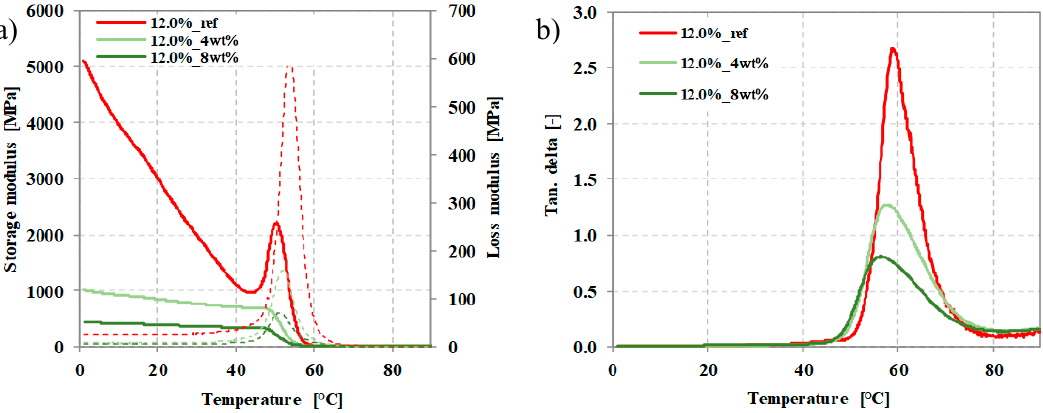
Figure 13. ( a ) Storage and loss moduli, ( b ) tan δ of the produced sheet foams as a function of temperature. Table 3. Dynamic properties of the produced sheet foams based on the DMA tests.